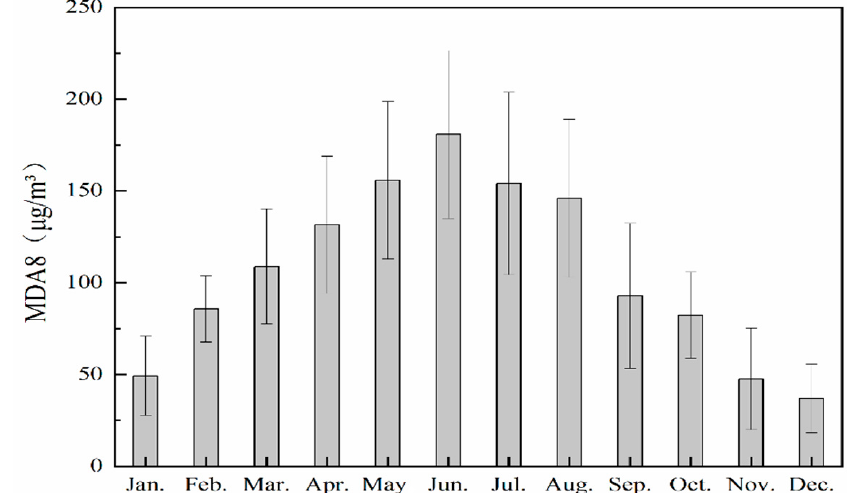
Figure 3. Monthly average of MAD8 in Taiyuan in 2018.